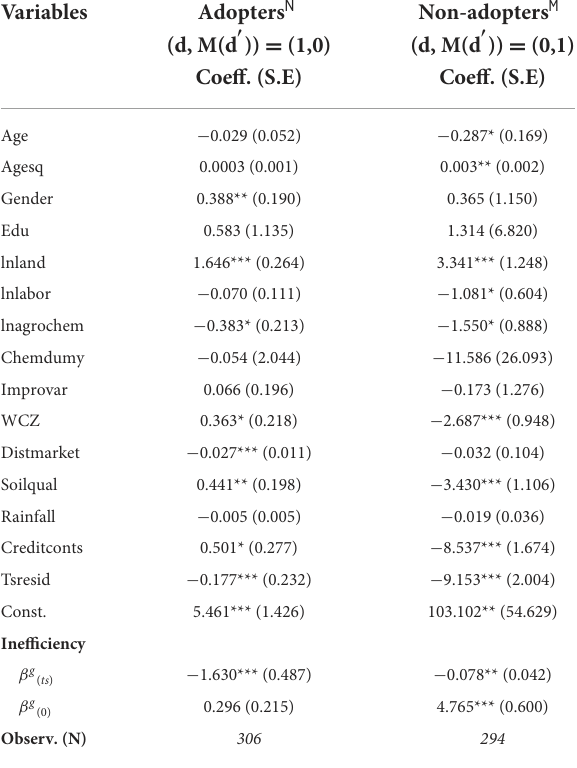
TABLE 5 Adoption without mediation—(weighted nonlinear least-squares)—farm net returns (lnGHC/Ha).